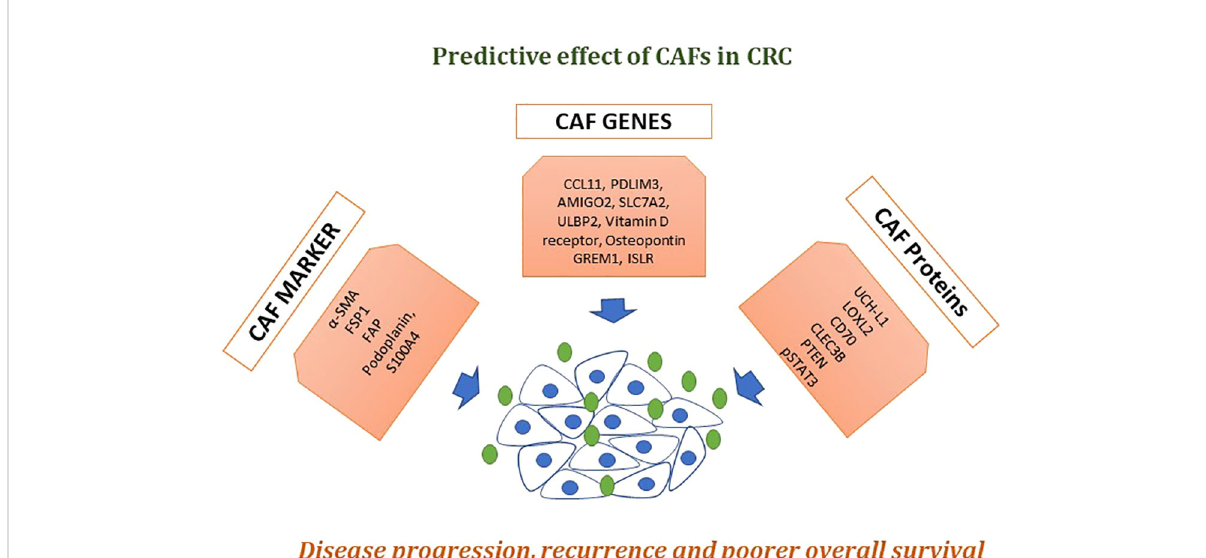
FIGURE 4 Effects of CAFs in CRC. A numeral of biomarkers that are extremely expressed in CAFs, like a -SMA, fi broblast activation protein alpha (FAP), fi broblast-speci fi c protein 1 (FSP-1), platelet-derived growth factor receptor- a (PDGFR a ) and PDGFR b have now been commonly used to classify or isolate CAFs from the pool of fi broblasts present in the whole body. Described genes and proteins showed poorer disease progression, recurrence-free survival, and overall survival. Taken together, these markers could be used as liquid biopsy approach for early detection and treatment prognosis in CRC patients.